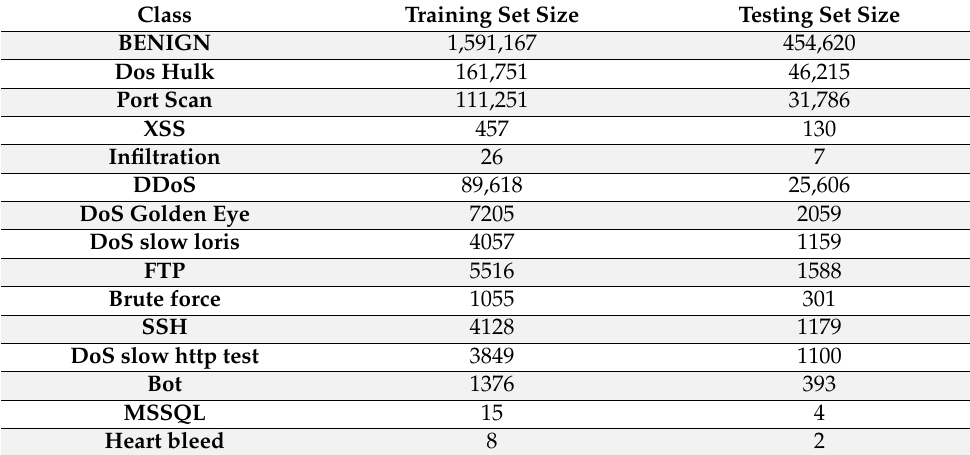
Table 6. CICIDS2017 data samples of each class.